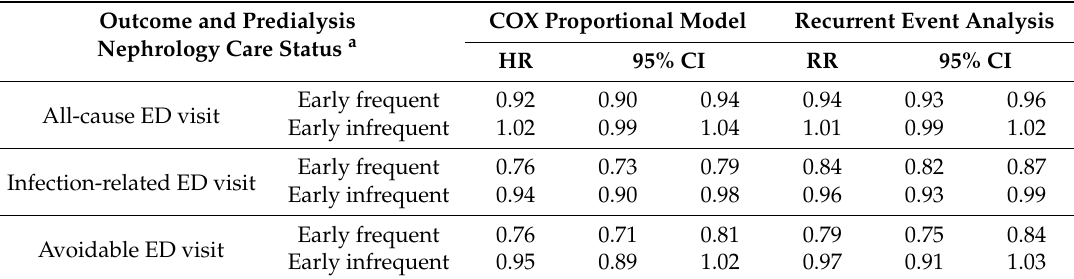
Table 3. Adjusted risk for 1-year EDs based on predialysis nephrology care status. Outcome and